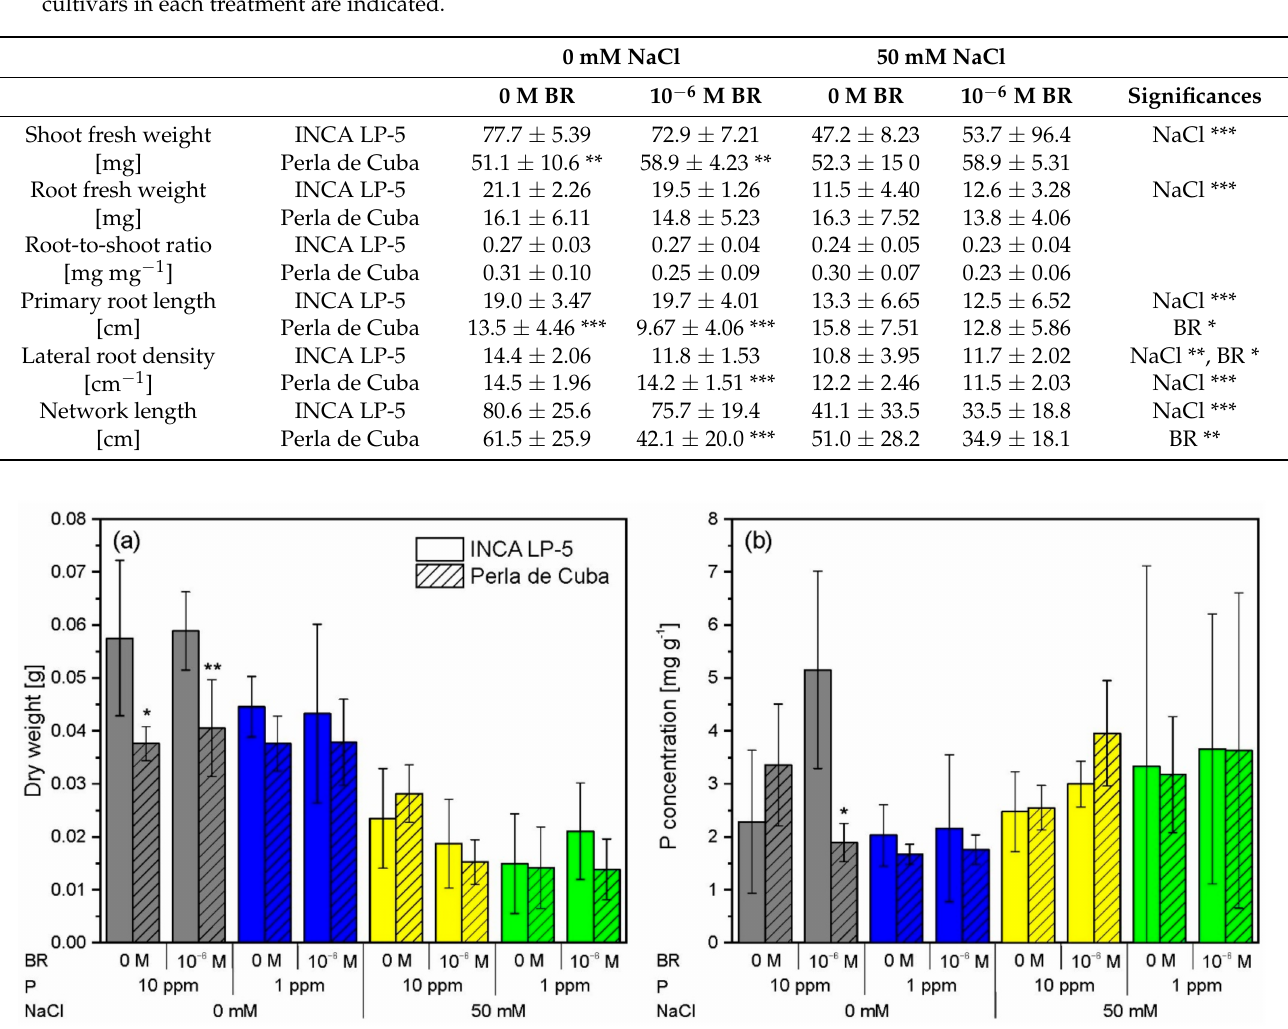
Figure 2. Dry weight ( a ) and phosphorus (P) concentration ( b ) of the two rice cultivars INCA LP-5 and Perla de Cuba after growth for three weeks in mini-rhizotrons treated with P depletion, NaCl or both and pre-treated with 24-epibrassinolide (BR). Means ± SD (n = 5). Differences between P ( p < 0.05) and NaCl ( p < 0.001) treatments were significant for dry weight in both cultivars; differences between NaCl treatments were significant for P concentration of Perla de Cuba ( p < 0.01, ANOVA). Significant differences between cultivars in each treatment are indicated with asterisks ( p < 0.05 * 0.01